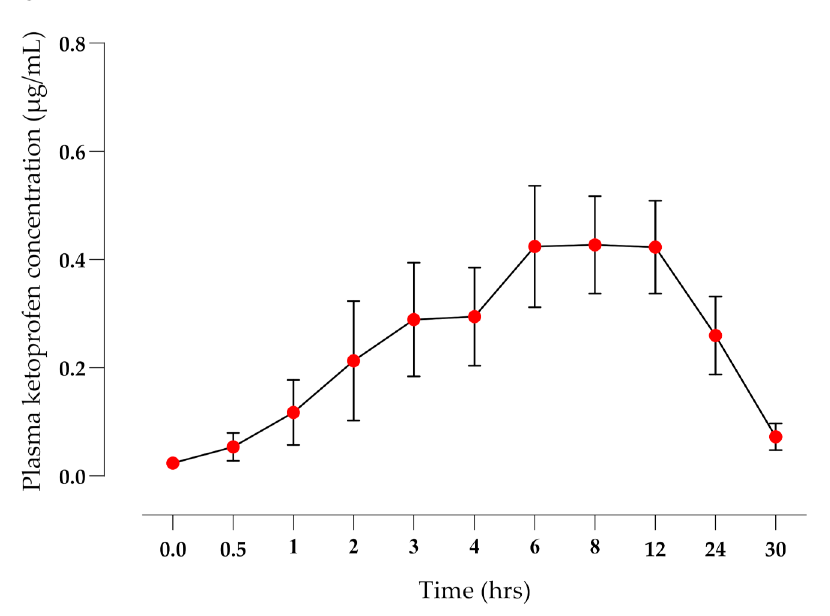
Figure 2. Plasma ketoprofen concentrations (mean ± SD) after IV administration (1 mg/kg) to healthy dogs ( n = 6).